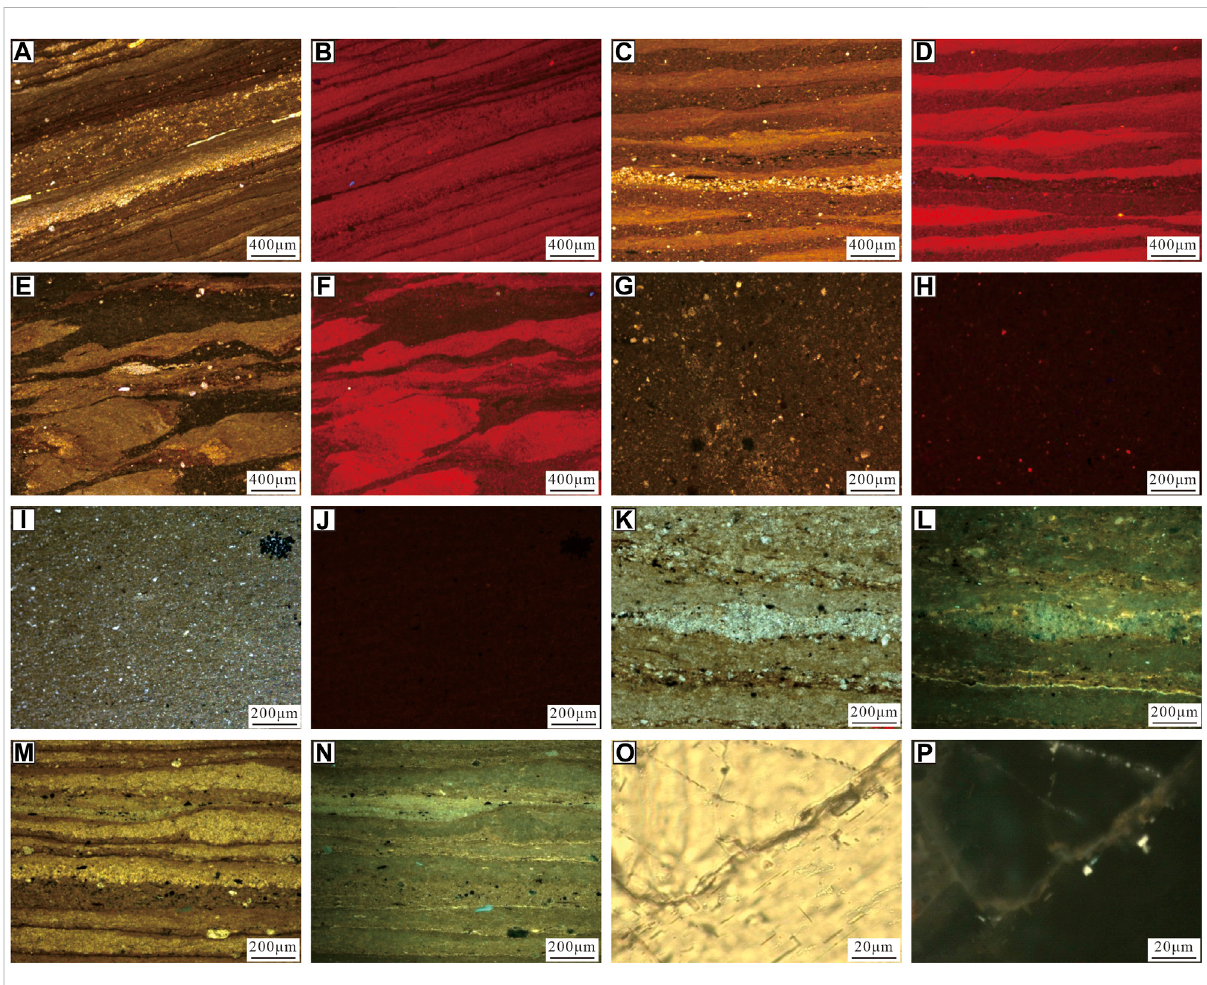
FIGURE 3 Petrographic characteristics of marl reservoir under single polarization (A,C,E,G,I,K,M,O) , cathode luminescence (B,D,F,H,J) , and fl uorescence microscopy (L,N,P) : (A,B) , laminated marl with different lamina thickness, ST3, 3,664.9 m; (C,D) , laminated marl of equal lamina thickness, ST3, 3,681.49 m; (E,F) , wavy laminated marl, ST3, 3,677.61 m; (G,H) , terrigenous massive marl, ST3, 3,817.65 m; (I,J) , endogenous massive marl, ST3, 4097.06 m; (K,L) , laminated marl of mechanical origin, ST3, 3,978.76 m; (M,N) , laminated marl of chemical origin, ST3, 3,675.09 m; (O,P) , massive marl, ST3, 3,983.83